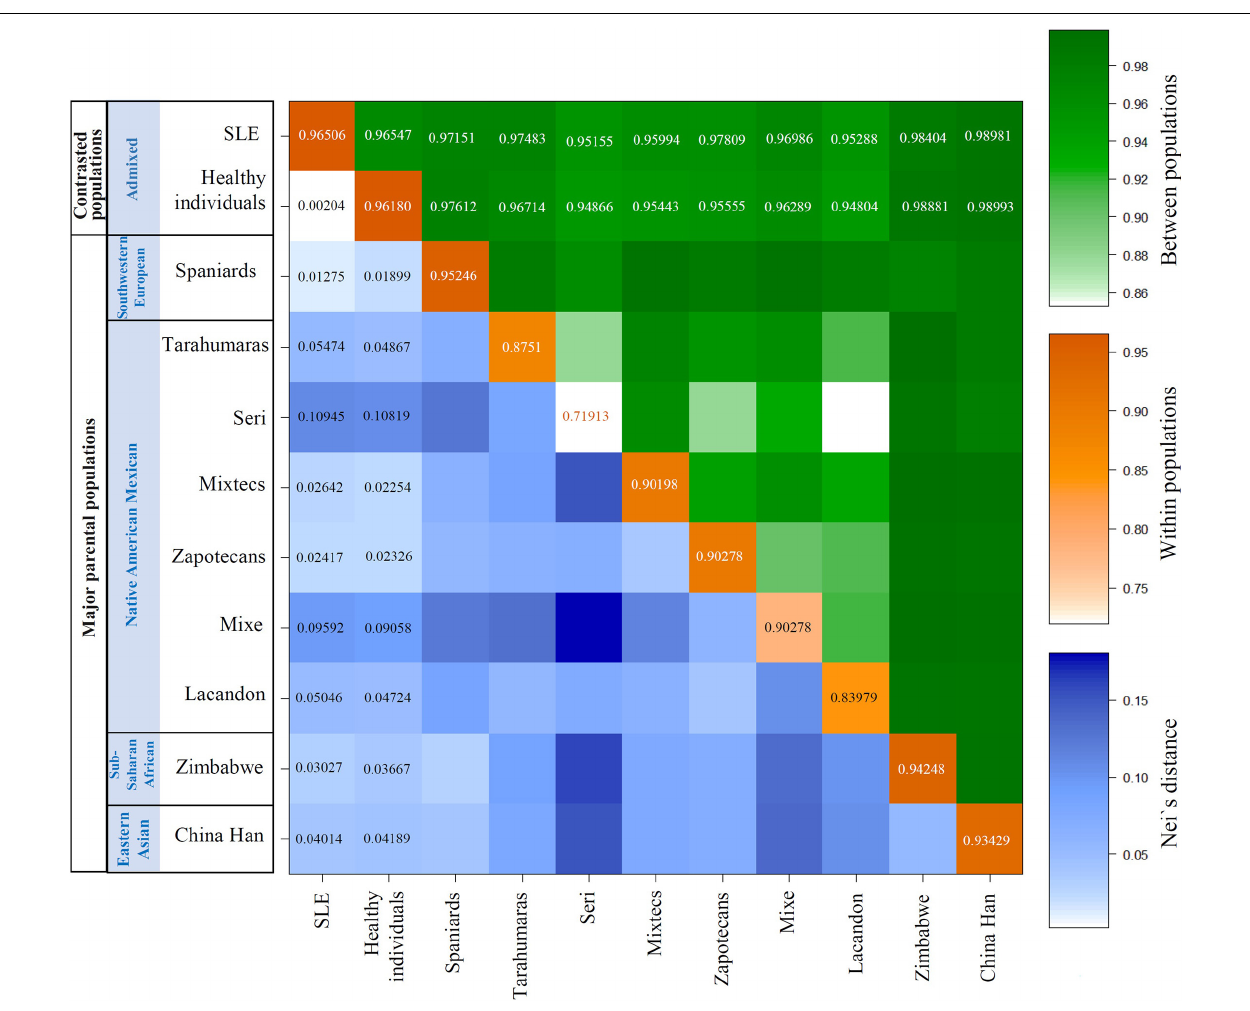
are shown in Tables 3 – 7 and Supplementary Tables 1–4